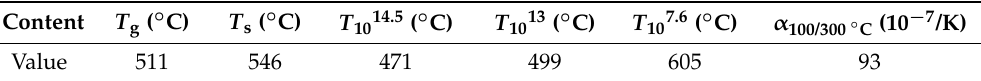
Table 1. The major thermal properties of D-ZK3 glass [42].